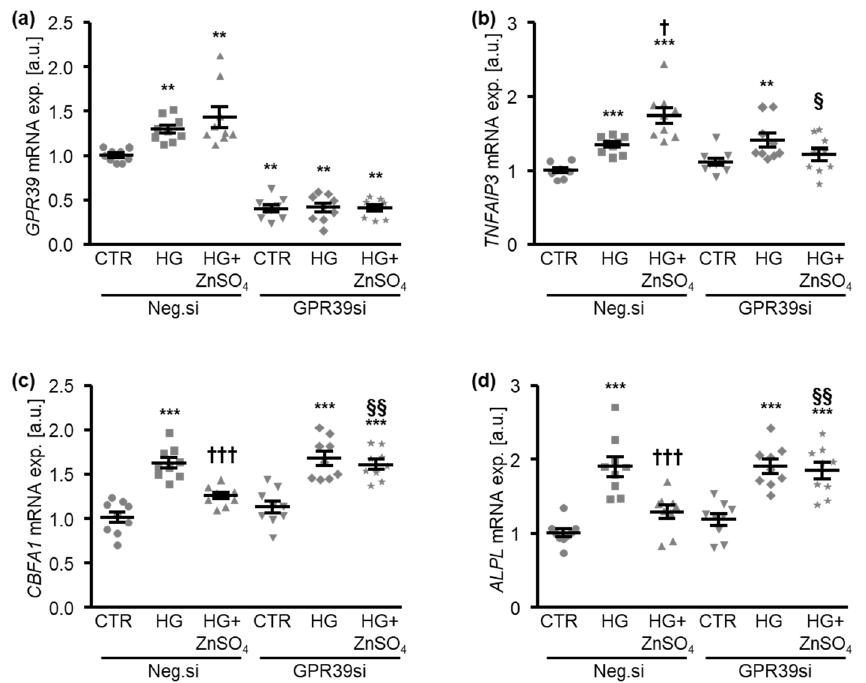
Figure 7. The silencing of GPR39 blunts the protective effects of zinc sulfate on high glucose-induced osteogenic marker expression in HAoSMCs. ( a ). Relative mRNA expression of GPR39 ( n = 9; arbitrary units, a.u.) in HAoSMCs transfected with negative control (Neg.si) or GPR39 (GPR39si) siRNA and treated for 24 h with control (CTR) or high glucose levels (HG) in the absence and presence of ZnSO 4 . ** ( p < 0.01) significant difference versus the Neg.si-transfected CTR-treated group. ( b – d ). Relative mRNA expression of TNFAIP3 ( b ), CBFA1 ( c ), and ALPL ( d ) ( n = 9; a.u.) in HAoSMCs transfected with negative control (Neg.si) or GPR39 (GPR39si) siRNA and treated for 24 h with control (CTR) or high glucose levels (HG) in the absence and presence of ZnSO 4 . ** ( p < 0.01), *** ( p < 0.001) significant difference versus the Neg.si-transfected CTR-treated group; † ( p < 0.05), ††† ( p < 0.001) significant difference between the Neg.si-transfected HG- and HG+ZnSO 4 -treated groups; § ( p < 0.05), §§ ( p < 0.01) significant difference between the Neg.si- and GPR39si-transfected HG+ZnSO 4 -treated groups.